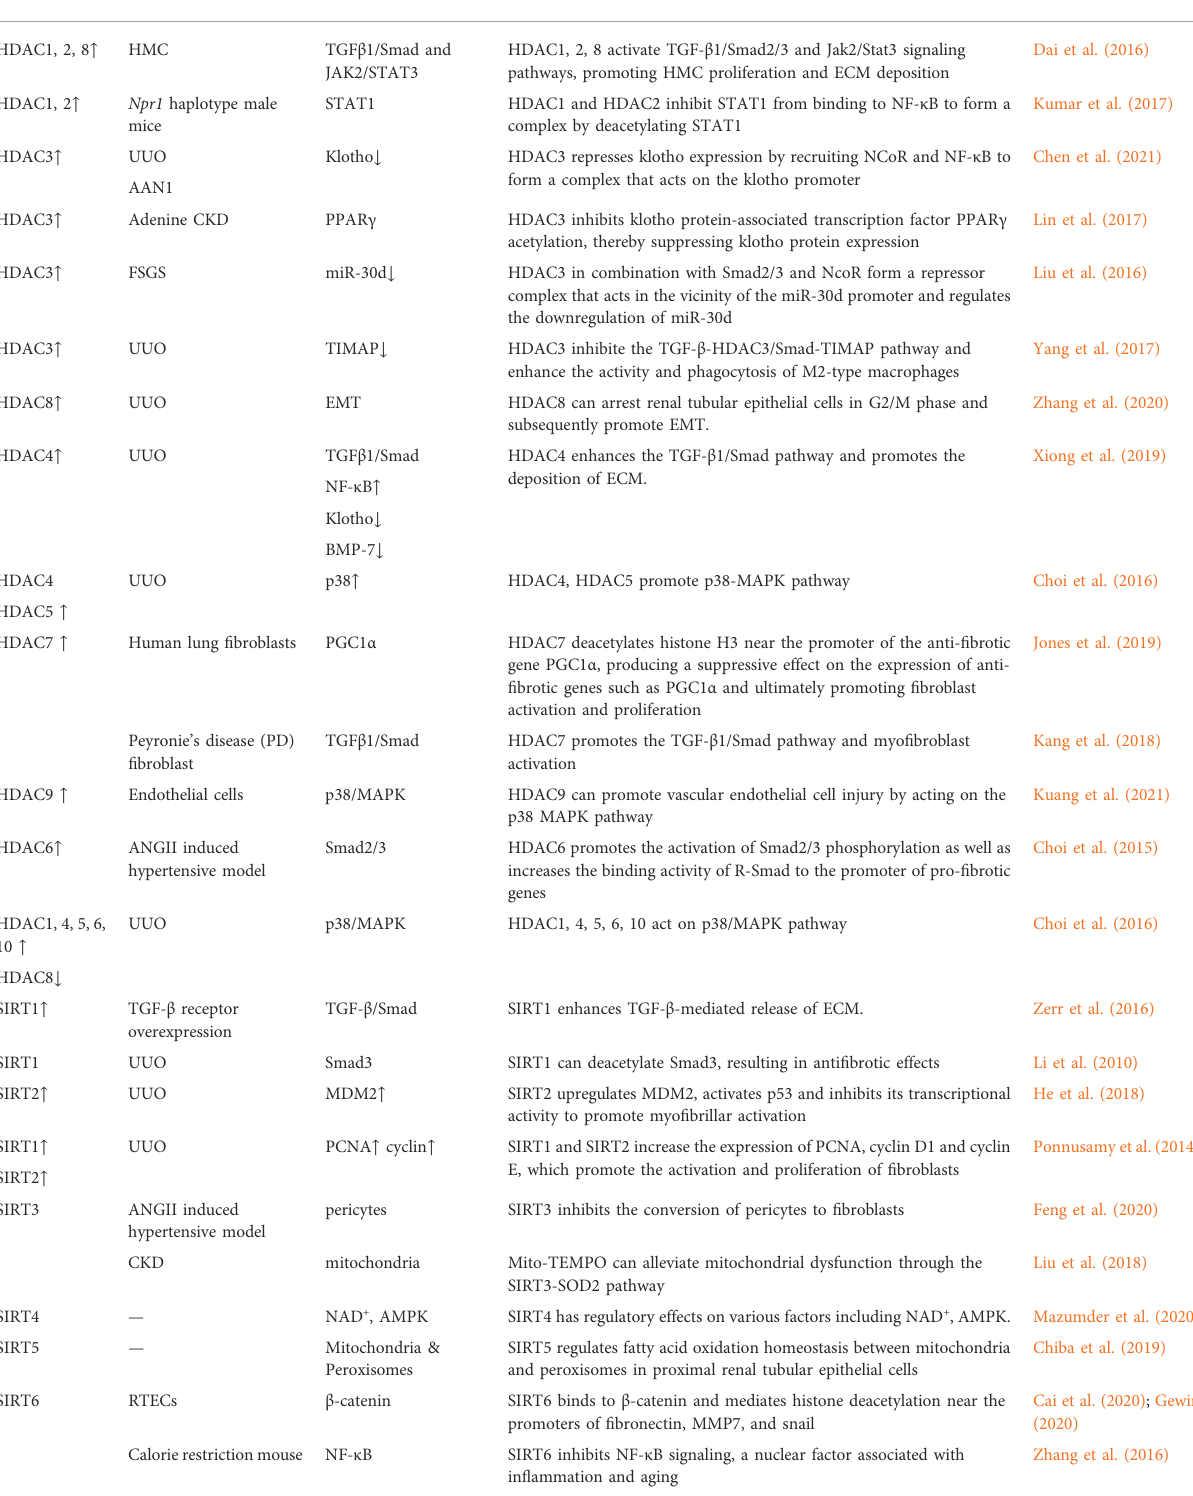
TABLE 1 Preclinical effects of HDAC superfamily regulate renal fi